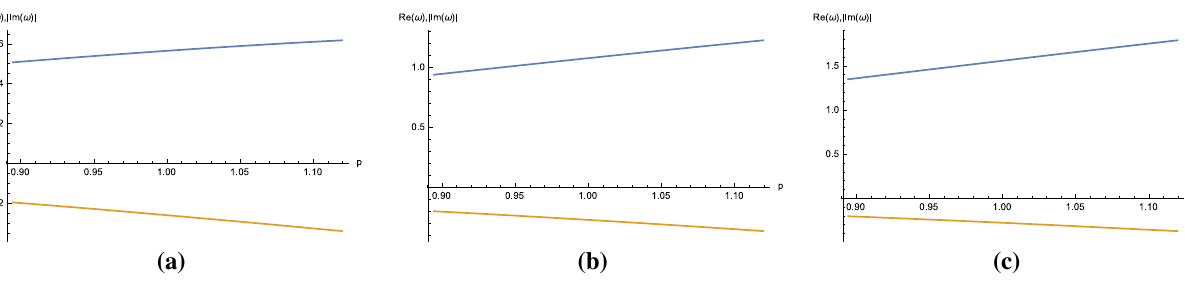
Fig. 2 The fundamental quasinormal mode ( n = 0) for the electromagnetic field ( s = 1), blue line is real part of frequencies, orange line is imaginary part: a l = 1; b l = 2; c l =